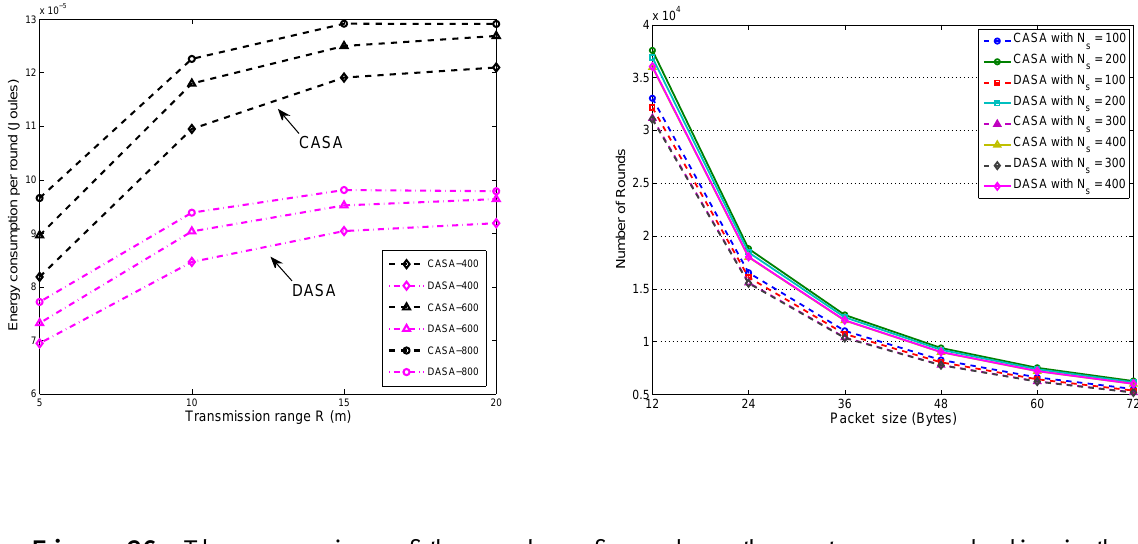
Figure 26. The comparison of the number of rounds as the first sensor node dies in the network using the LEACH, MECH (10 members), CASA, and